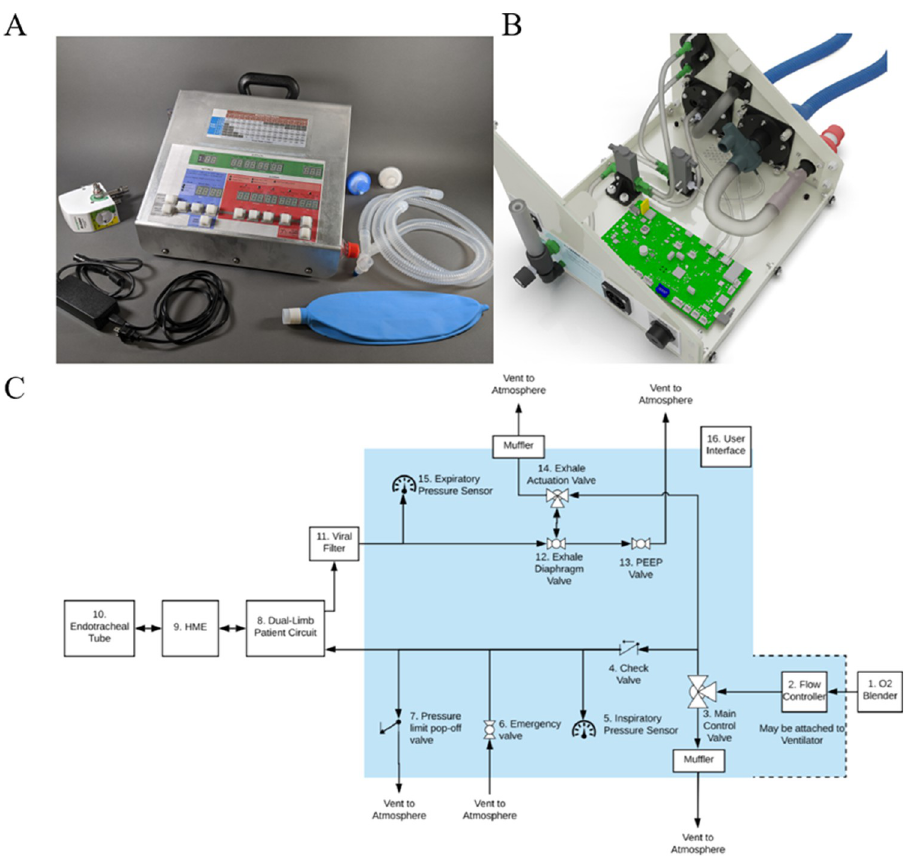
Fig 1. Design of the O2U ventilator. A prototype of the new O2U ventilator, designed and built in the early months of the COVID-19 pandemic shown with accessories (A), the internal construction (B) and the prototype schematic (C) showing the gas pathway internal components (within the shaded region) and the relevant accessories and component required (non-shaded).